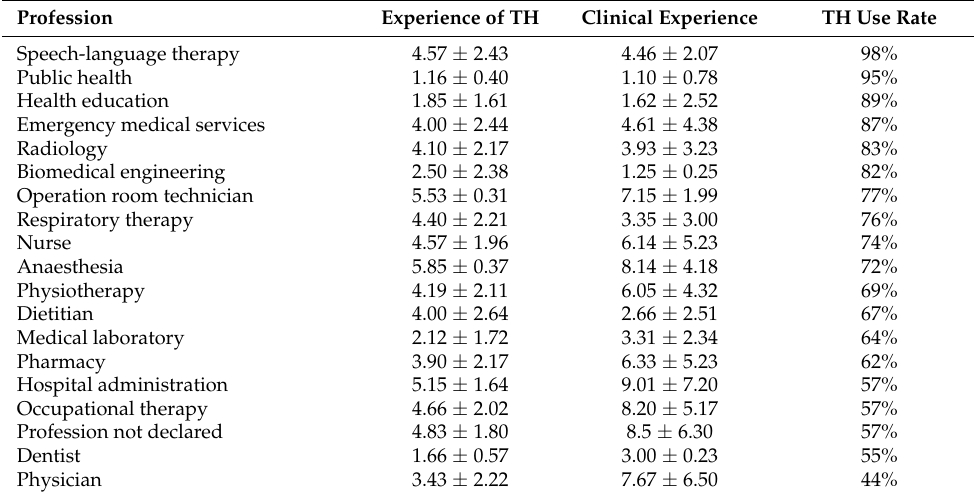
Table 3. Telehealth Use Experience and Rate per Profession in Saudi Arabia ( n =